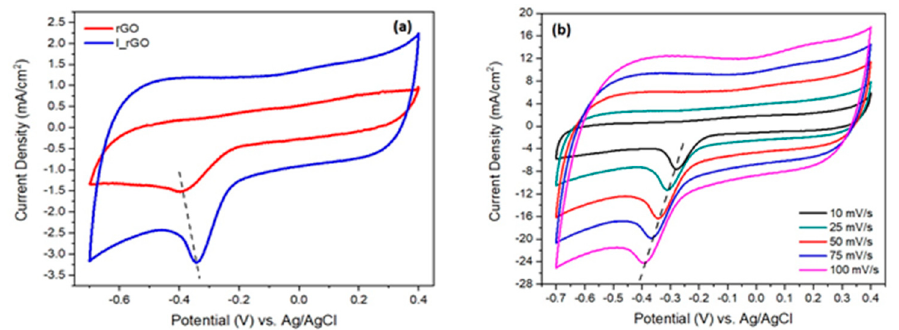
Figure 7. ( a ) Cycling voltammograms of reduced graphene oxide (rGO) and iodine − doped rGO (I/rGO) recorded between 0.4–0.7 V vs. Ag/AgCl, in oxygen atmosphere, scanned with 50 mV/s; ( b ) cycling voltammograms of I/rGO at different sweeping rates.